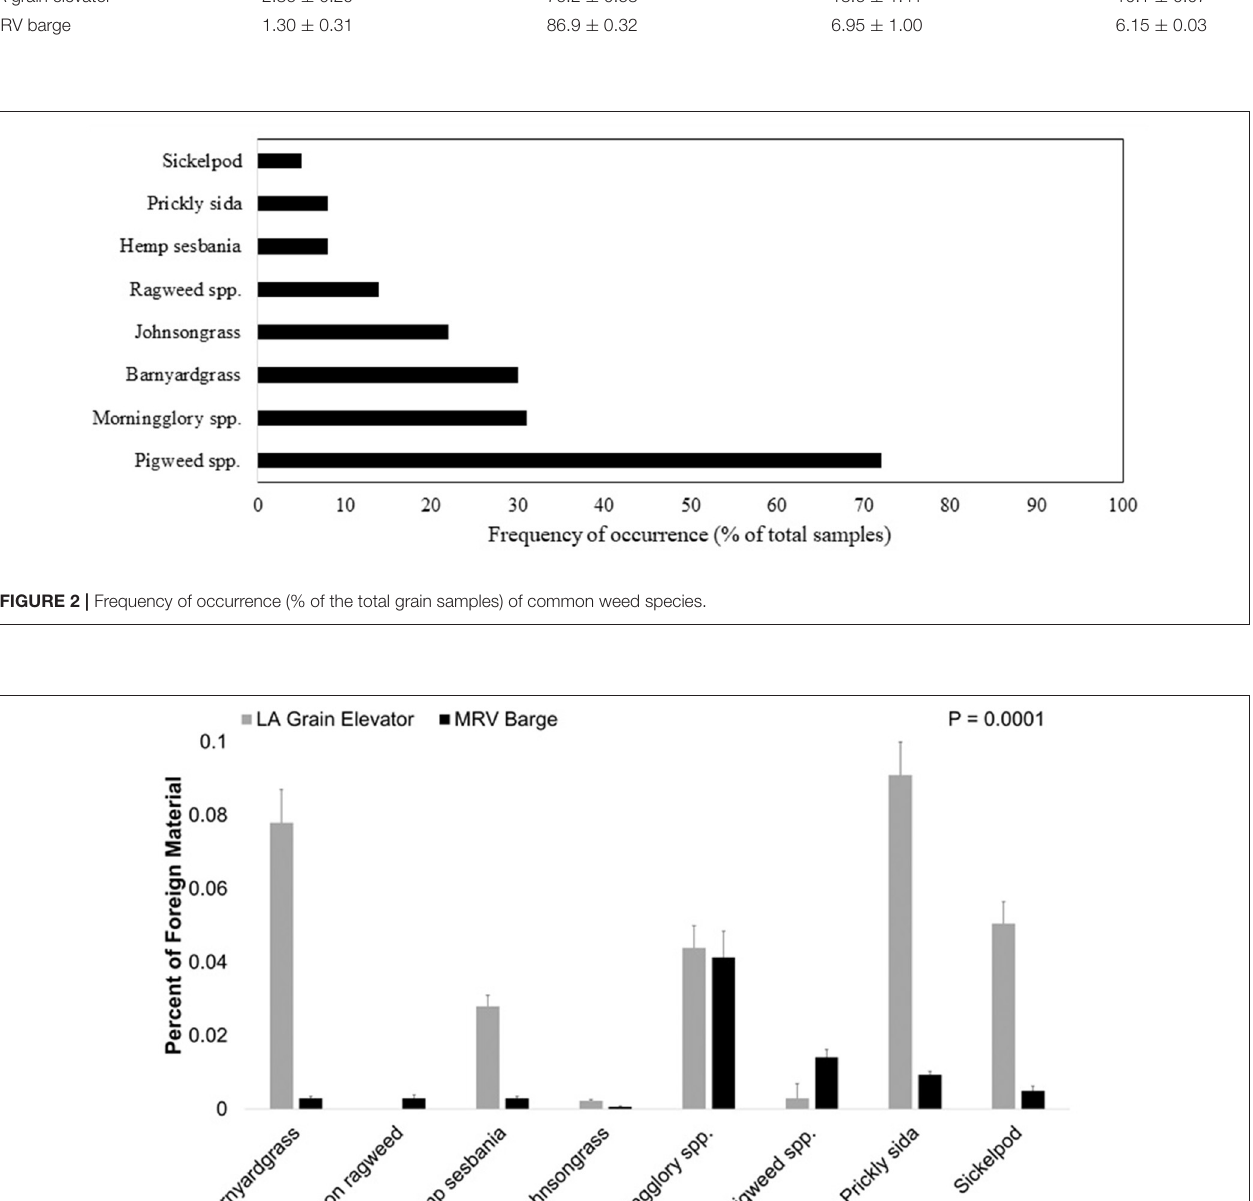
Frontiers in Agronomy |